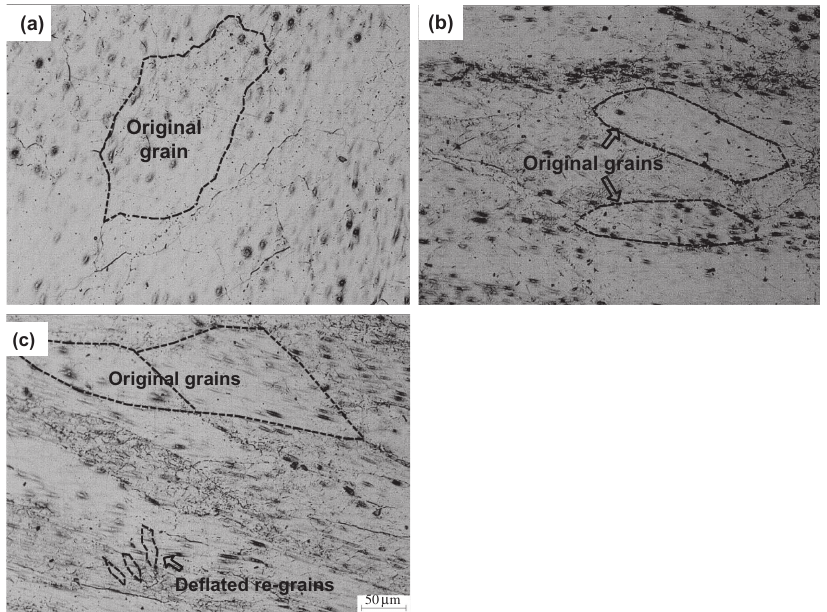
Figure 7: Microstructure evolution under the temperature of 1,030°C and the strain rates of (a) 0.1 s − 1 , (b) 1 s − 1 and (c) 10 s − 1 .